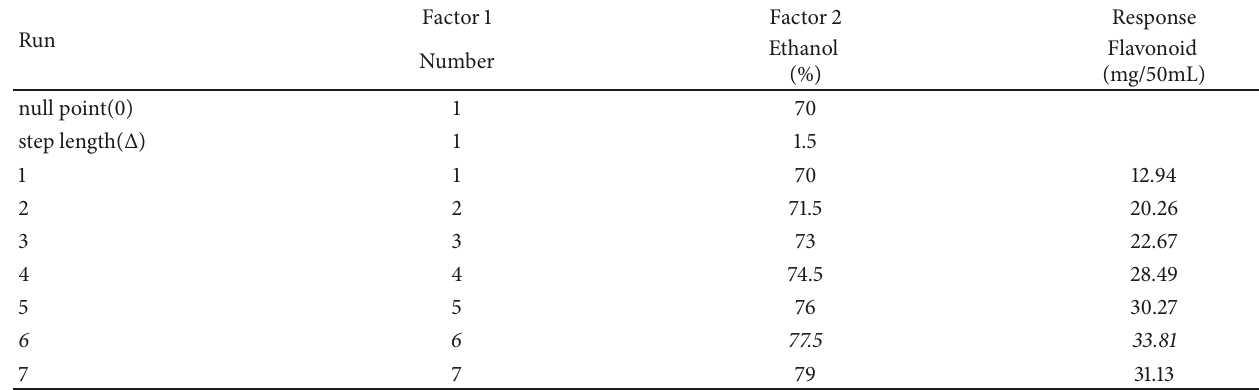
Table 2: Path of steepest ascent experimental design and results.